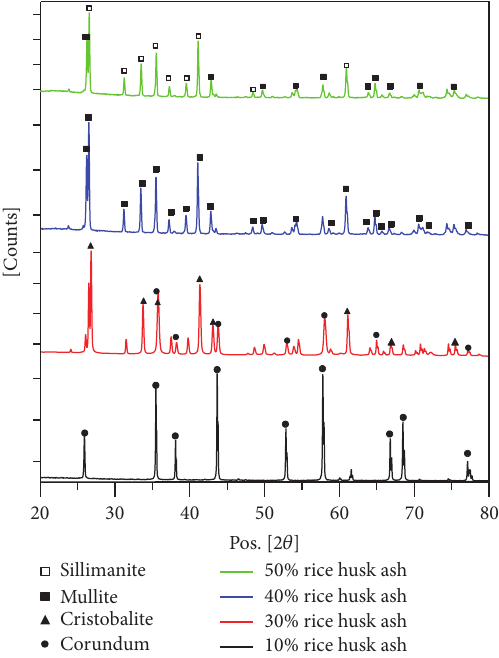
Figure 7: XRD pattern for the porous alumina samples sintered at 1600 ∘ C for 2hrs with rice husk ash.